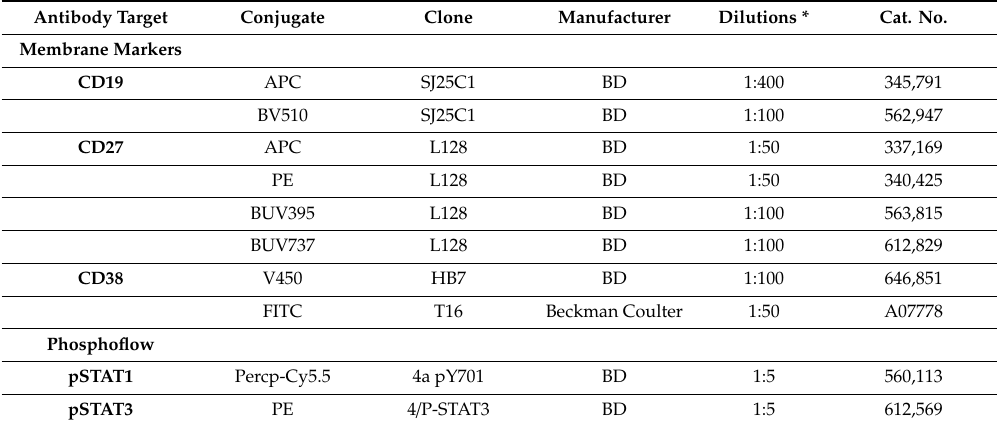
Table 1. Antibodies used for phospho-specific and transcription factor flow